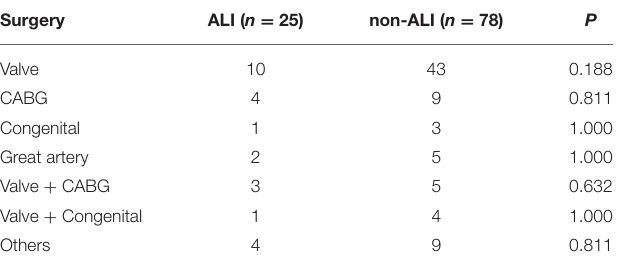
TABLE 2 | The operation data between the ALI and non-ALI groups.